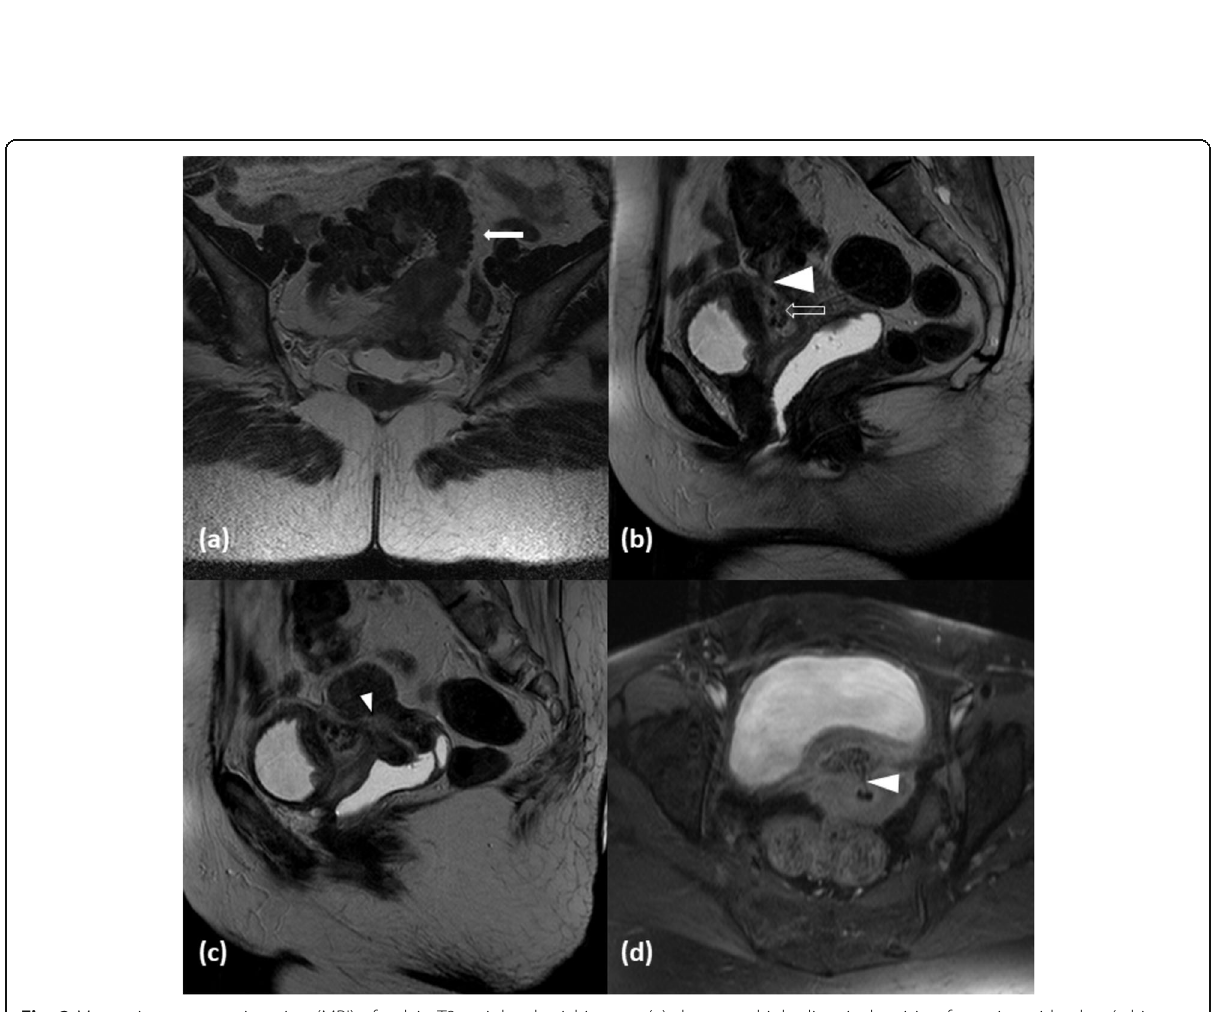
Fig. 2 Magnetic resonance imaging (MRI) of pelvis: T2-weighted axial images ( a ) shows multiple diverticula arising from sigmoid colon (white solid arrow in a ). T2-weighted sagittal images ( b and c ) show a heterogeneous intensity collection representing abscess in the utero-vesical space (void white arrow in b ) which is arising from the sigmoid colon (white arrowhead in b ). The fistulous communication (solid white arrowheads in c and d ) between the abscess and the uterine cavity is well seen on T2-weighted images ( c ) and T1-weighed post-contrast axial images ( d